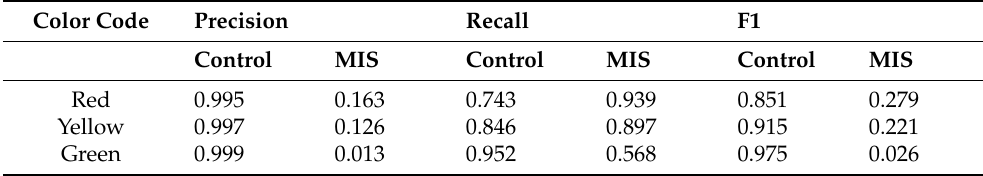
Table A4. Logistic regression performance across color